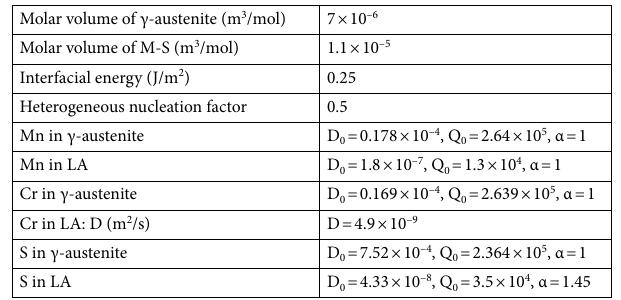
Table 4. Precipitation kinetics model parameters 41,44